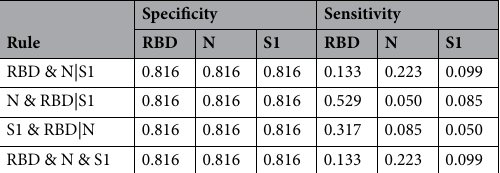
Table 3. Power calculations for the comparison of specificity and sensitivity between single-antigen tests and rules for total antibody